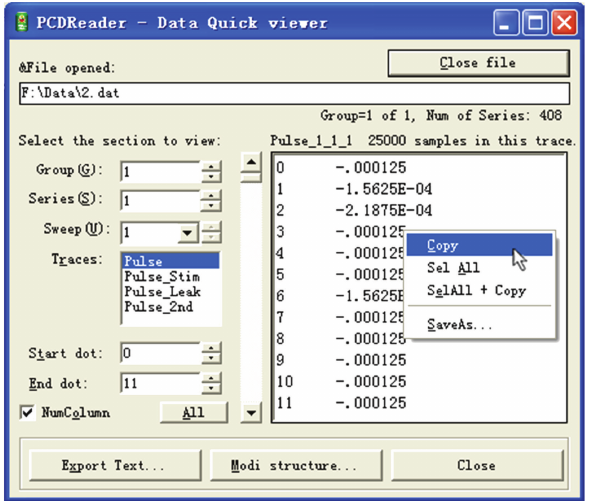
Figure 2: Raw data quick viewer in PCDReader software.